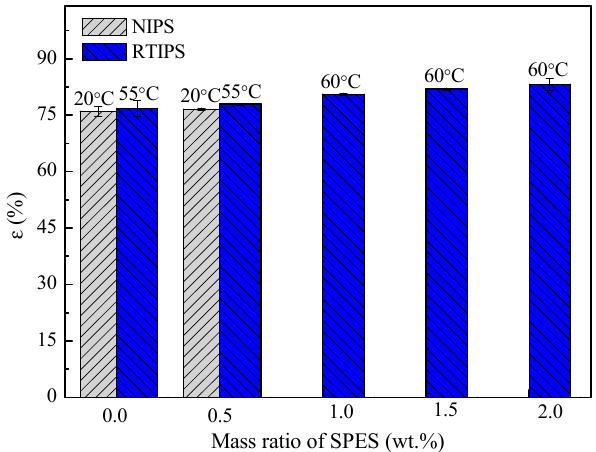
Figure 9. Porosity of the prepared PES hollow fiber membranes.